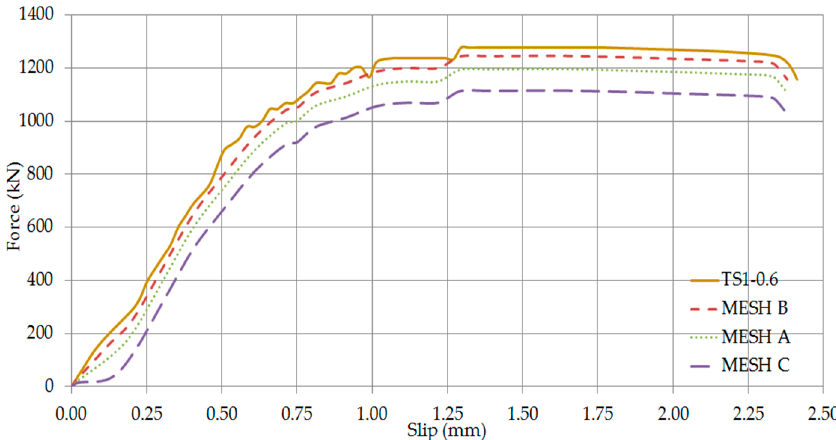
Figure 19. Axial force—Shortening Curves of H16/490-T6B30 (Comparison of mesh densities).